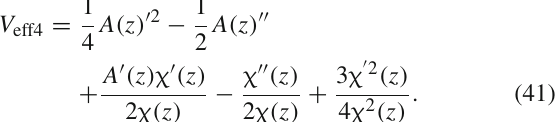
Fig. 3 The effective potentials V eff3 and V eff4 in a degenerated Bloch